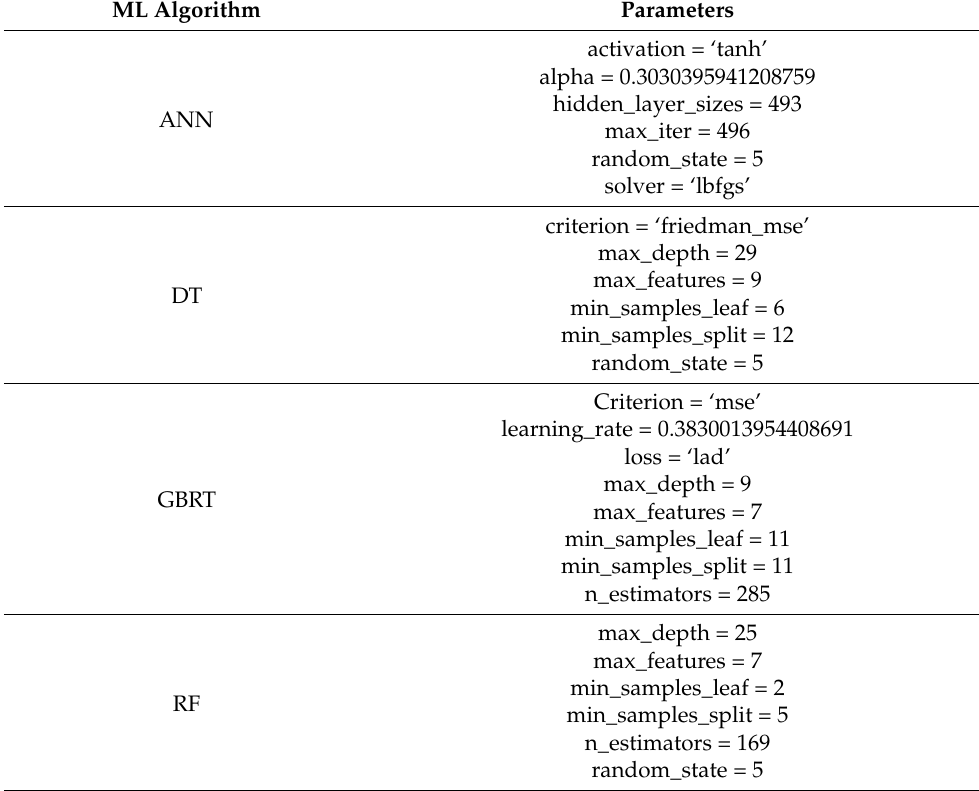
Table 7. Optimized parameters of the four ML algorithms.